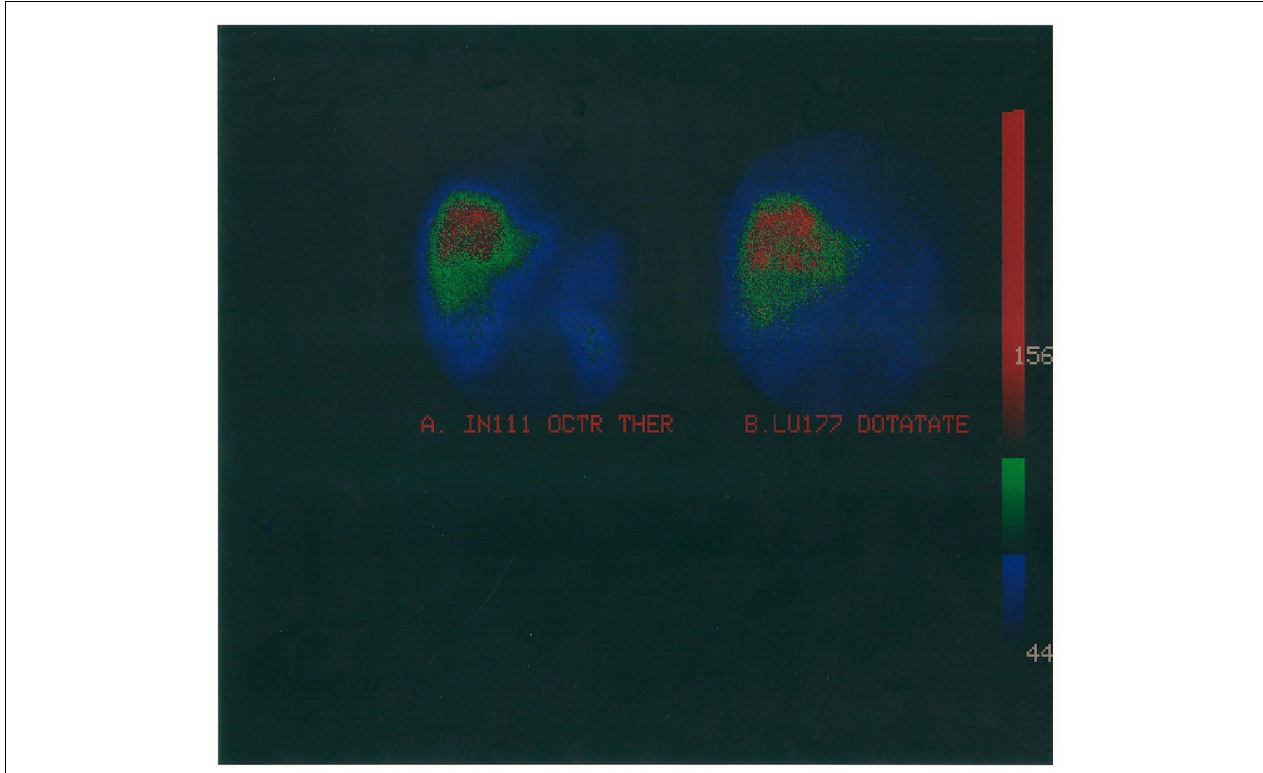
FIGURE 1 | Radiomolecular combined therapy of multiple liver metastases originated from a resected pancreatic neuroendocrine tumor treated with high doses of (A). In-111 Pentetreotide and (B) Lu-177 DOTATATE.